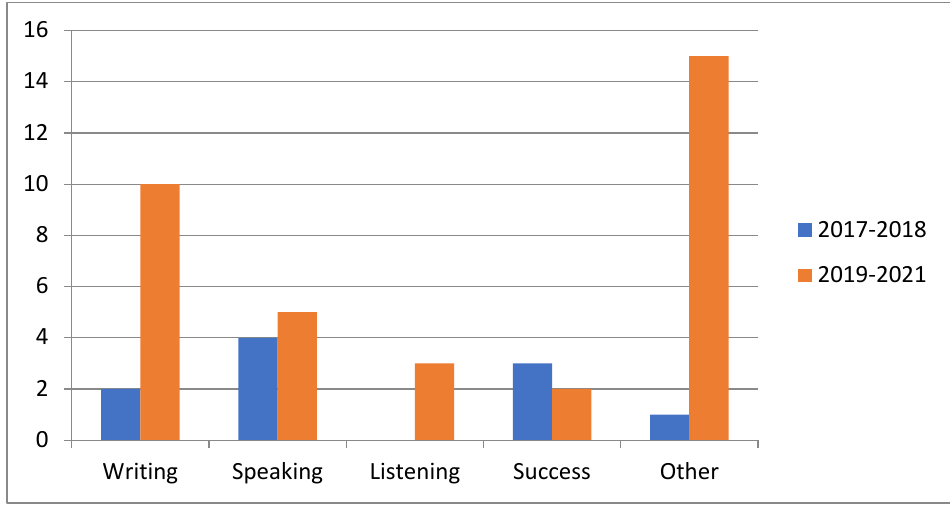
Figure 2. Types of topics discussed in the studies between 2017 ‐ 2018 and 2019 ‐ 2021. RQ3: What is the trend of the flipped classroom approach used before and during the COVID ‐ 19 pandemic?